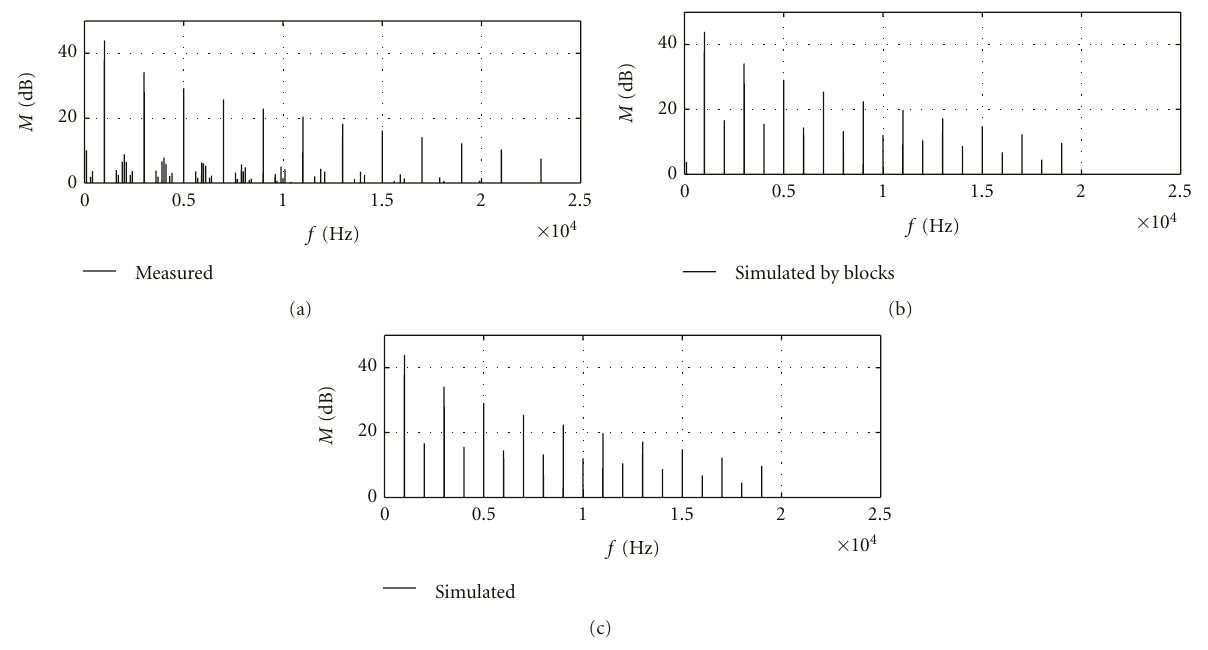
Figure 11: Spectrum comparison between measured and simulated